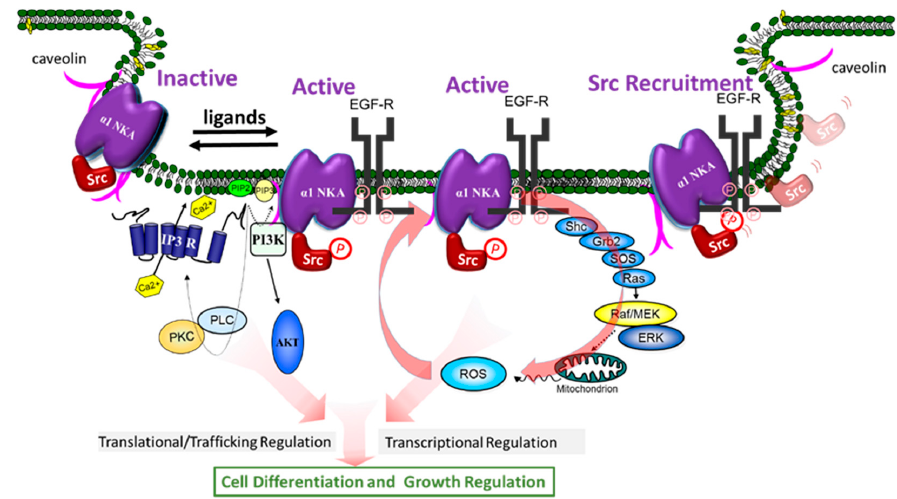
Figure 2. Schematic presentation of NKA-mediated signal transduction through direct protein interactions. EGFR, EGF receptor; PLC, phospholipase C; PKC, protein kinase.